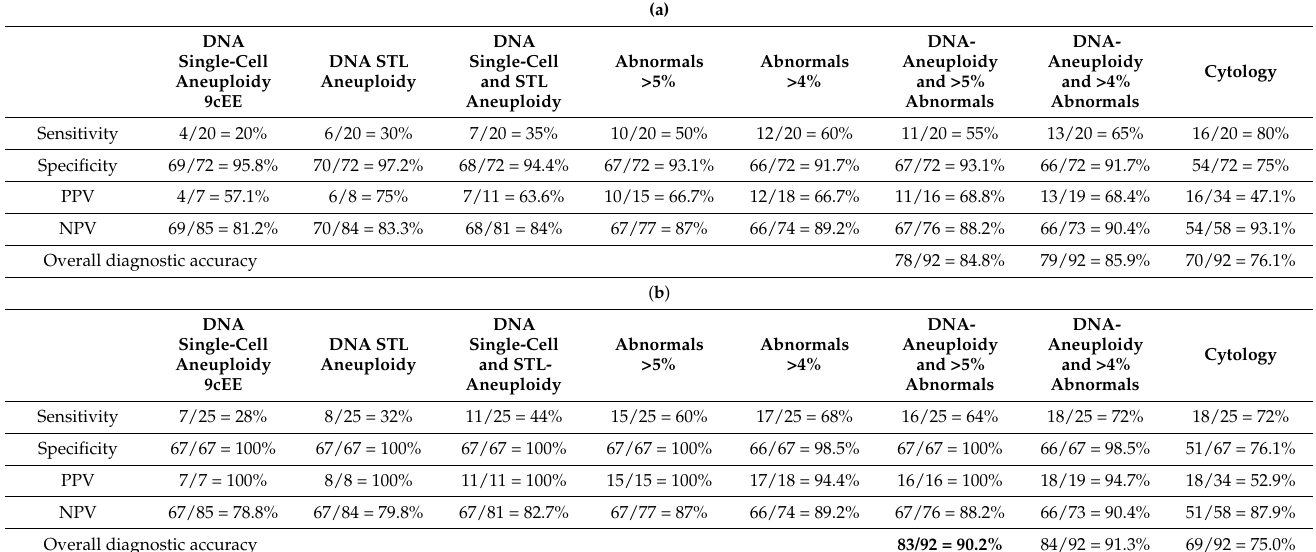
Table 1. ( a ) Accuracy of different diagnostic algorithms in 92 oral smears from patients with FA, scanned with EasyScan-AI. Original follow-up. ( b ) Accuracy of different diagnostic algo- rithms in 92 oral smears from patients with FA, scanned with EasyScan-AI. Modified follow-up. Bold : original